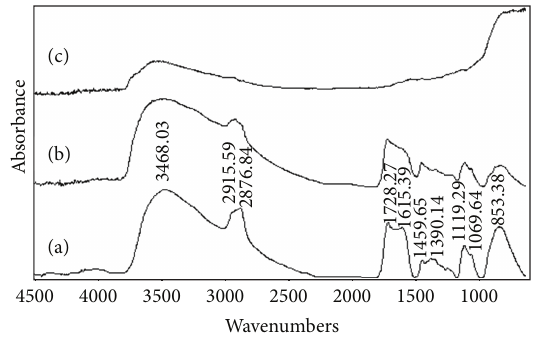
Figure 2: DRIFT spectra of (a) Al Na and (b) Al CNa .